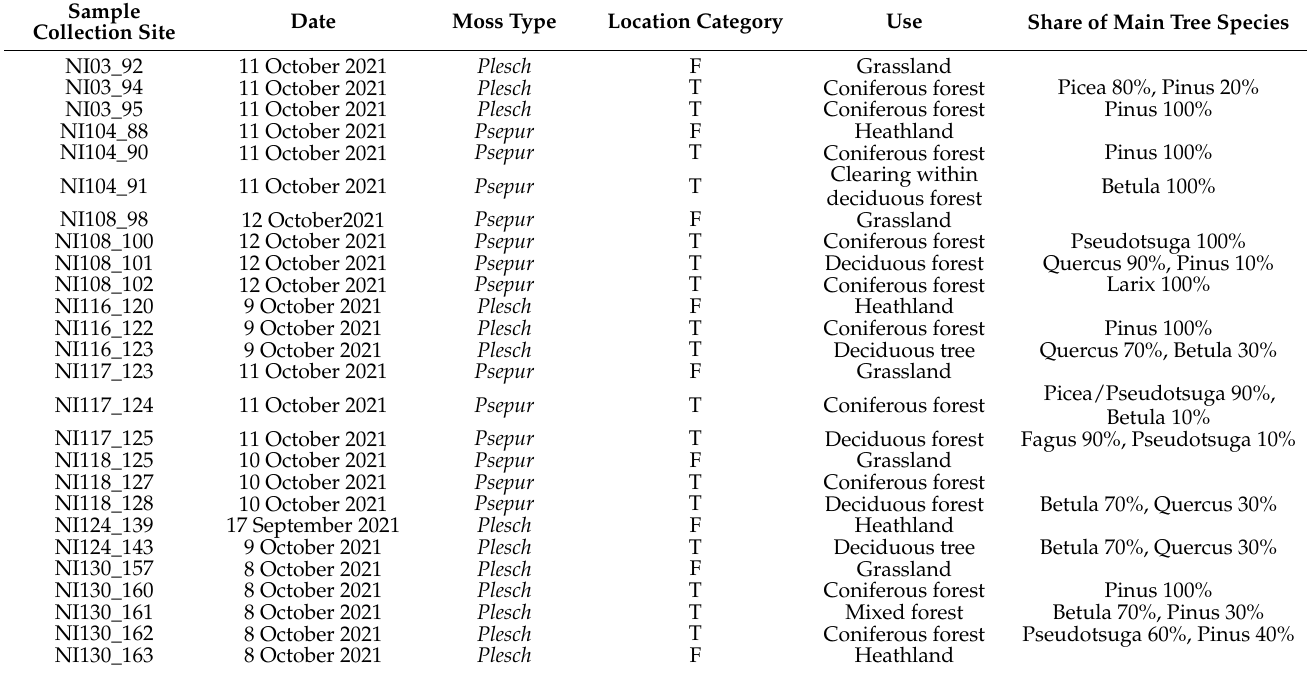
Table 1. Sampling sites ( n = 26) in northwest Germany